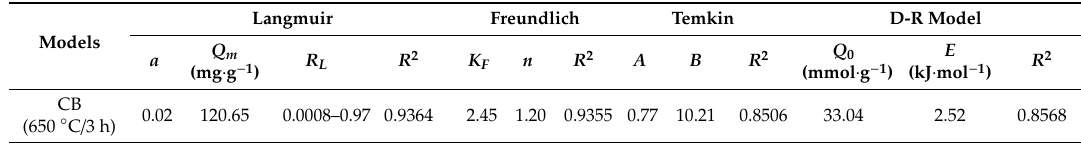
Table 3. Isothermal adsorption fitting parameters of CB for NO 3 −